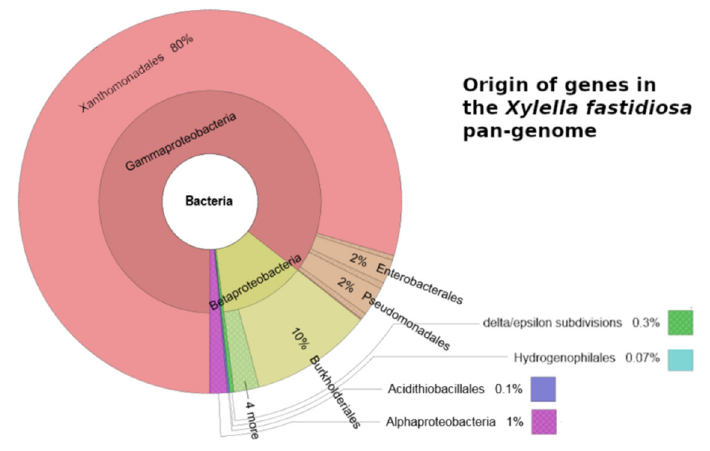
Figure 1. Taxonomic subdivision of the nearest ortholog assignment of all genes in the Xylella fastidiosa pan-genome. It appears that about 20% of the total genes of Xylella fastidiosa have been acquired from distantly related bacterial taxa. (Data from [18]).